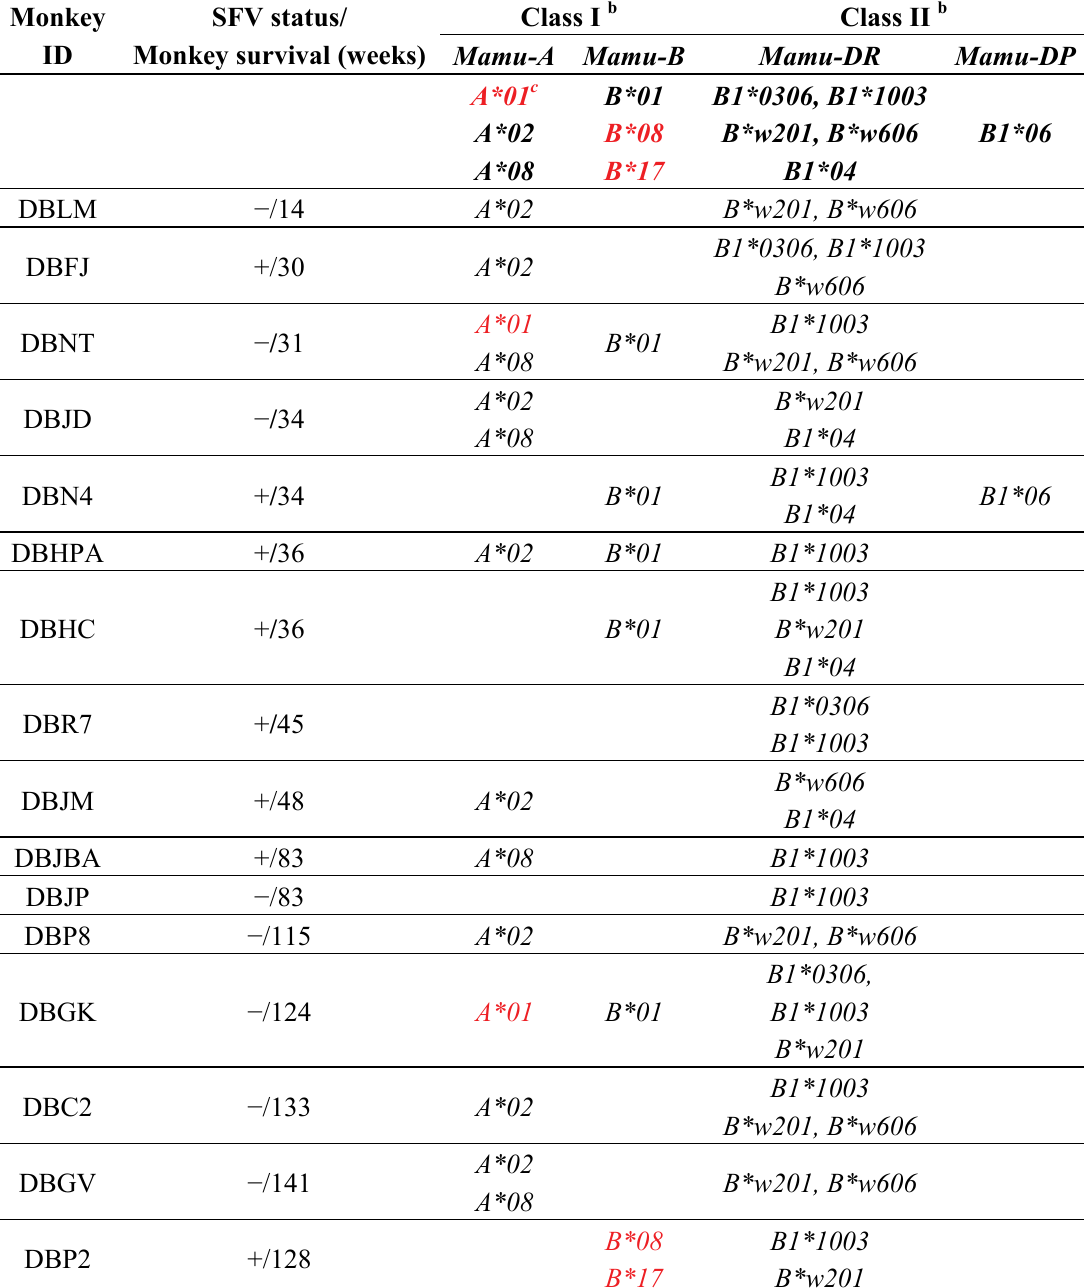
Table 2. MHC genotyping of SIV-infected monkeys a